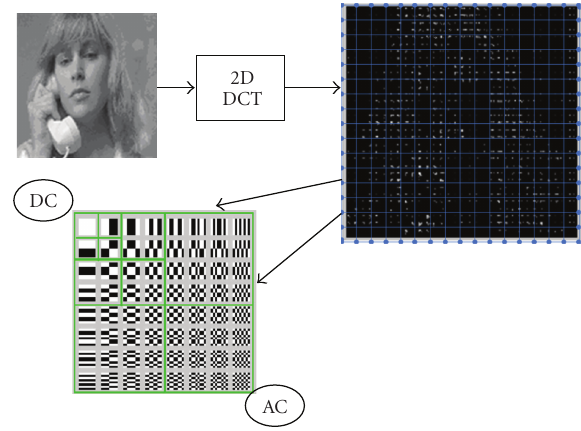
Figure 1: The original image transformation with block